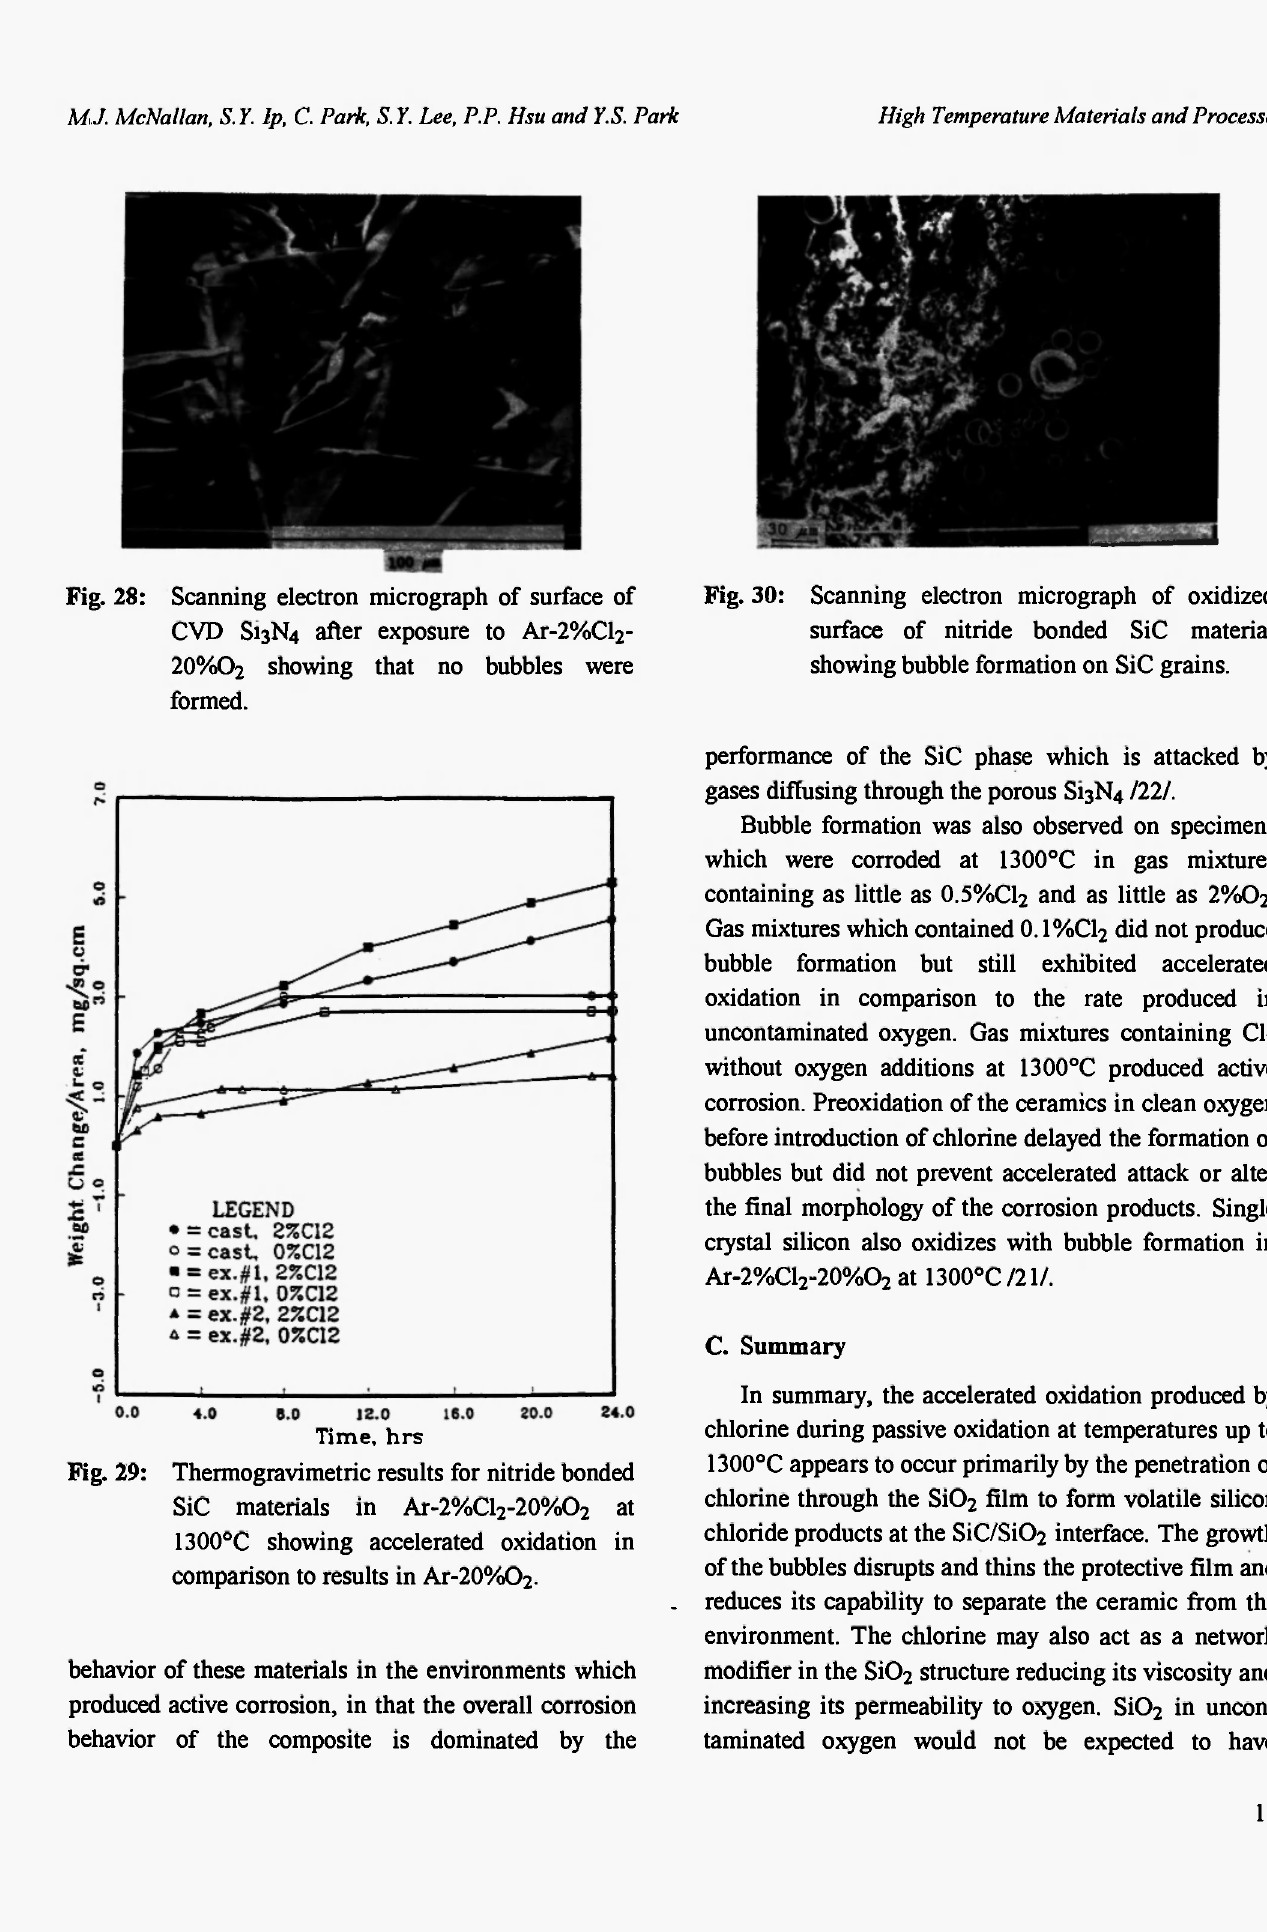
Fig. 29: Thermogravimetric results for nitride bonded SiC